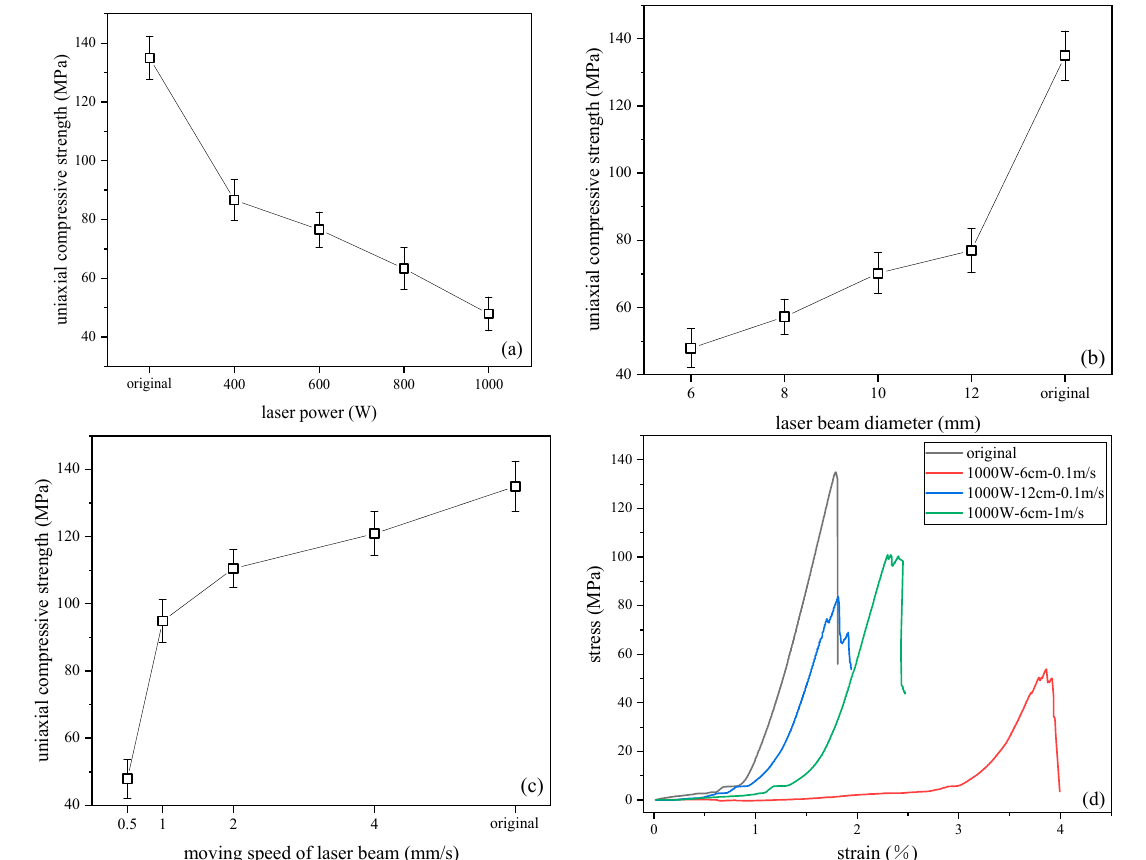
Figure 3. Uniaxial compressive strength versus ( a ) laser power, ( b ) laser-beam diameter, ( c ) moving speed of laser beam, ( d ) uniaxial compressive strength–strain curve.